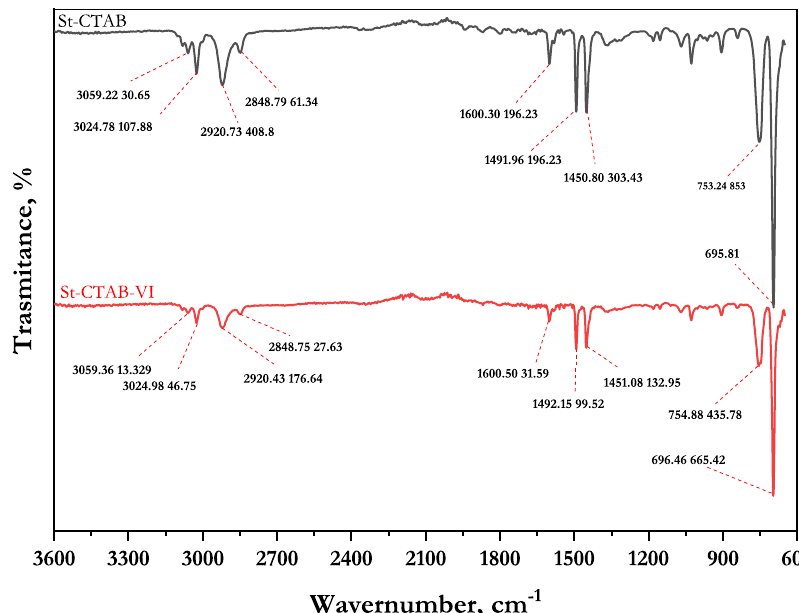
Figure 1. Fourier-Transform Infrared (FTIR) spectra of St-CTAB and St-CTAB-VI.